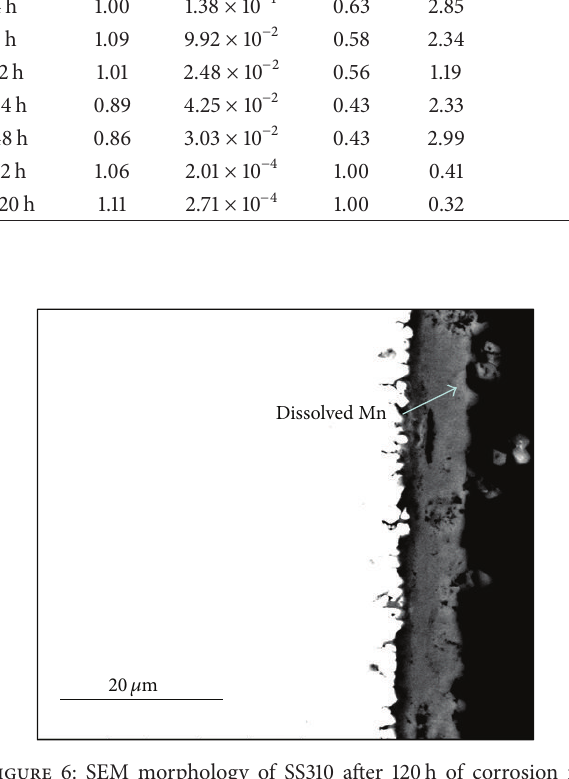
Figure 6: SEM morphology of SS310 after 120h of corrosion in molten